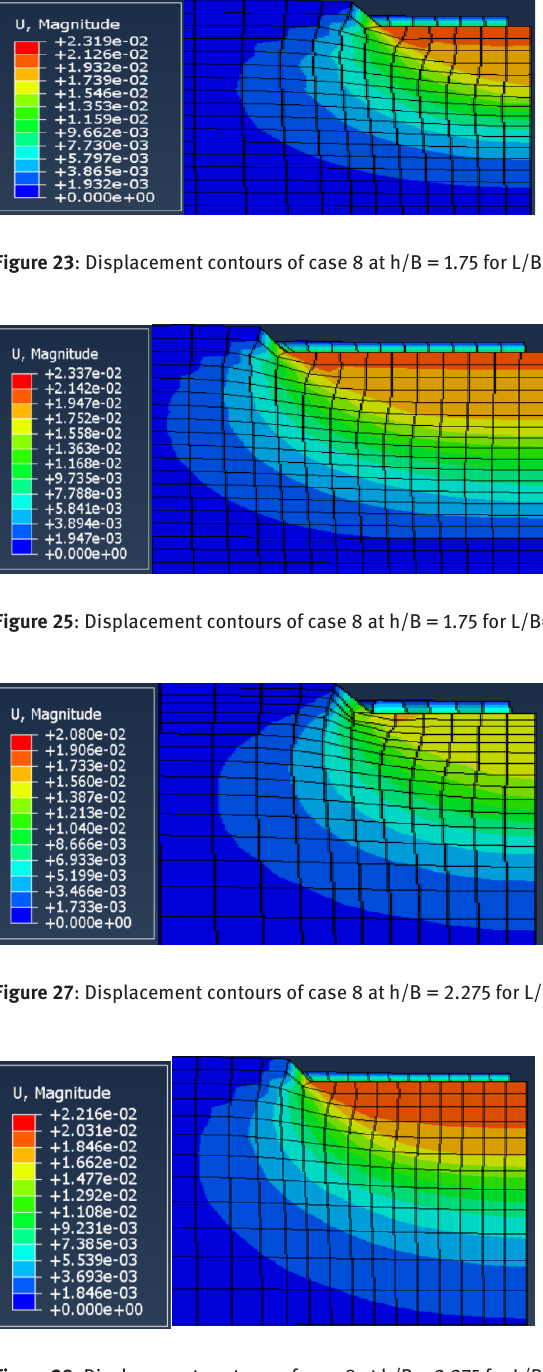
Figure 28 : Displacement contours of case 1 at h/B = 2.275 for L/B=2. Figure 29 : Displacement contours of case 8 at h/B = 2.275 for